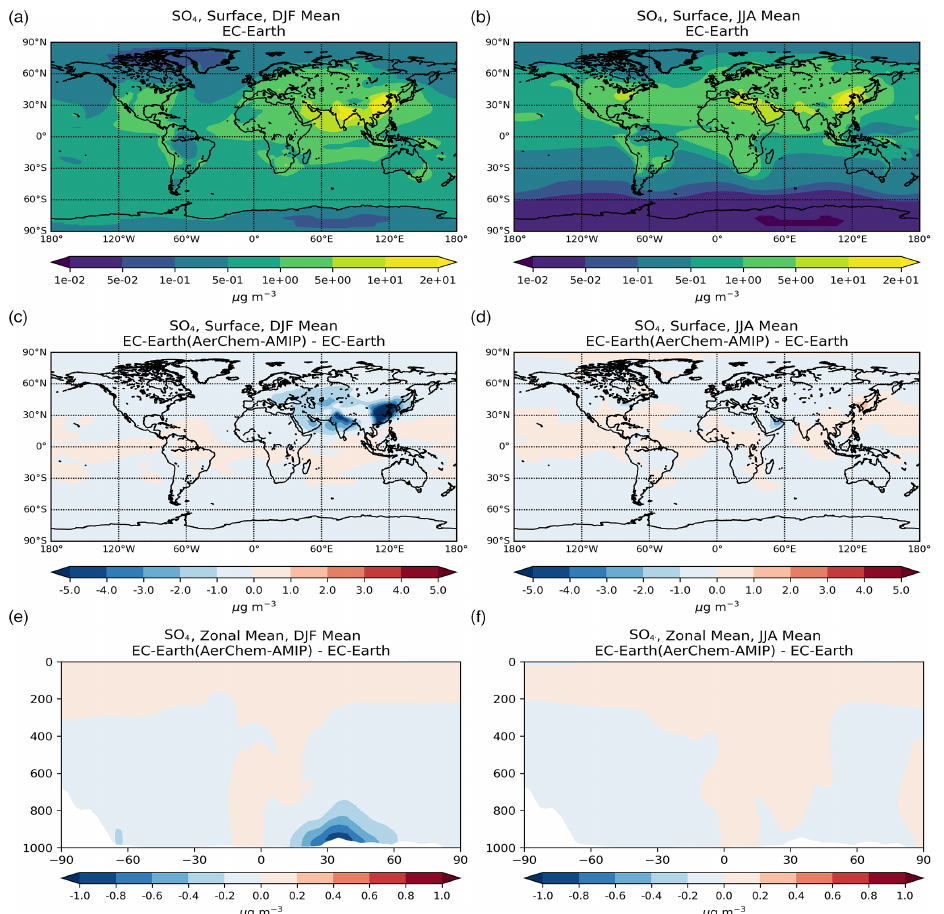
Figure 7. Sulfate (SO 4 ) surface concentrations (µgm − 3 ) for boreal winter (DJF; a ) and boreal summer (JJA; b ), as simulated for the EC- Earth simulation averaged for the period 2000–2014, and the respective absolute differences with the EC-Earth(AerChem-AMIP) simulation for surface (c, d) and zonal mean (e, f)